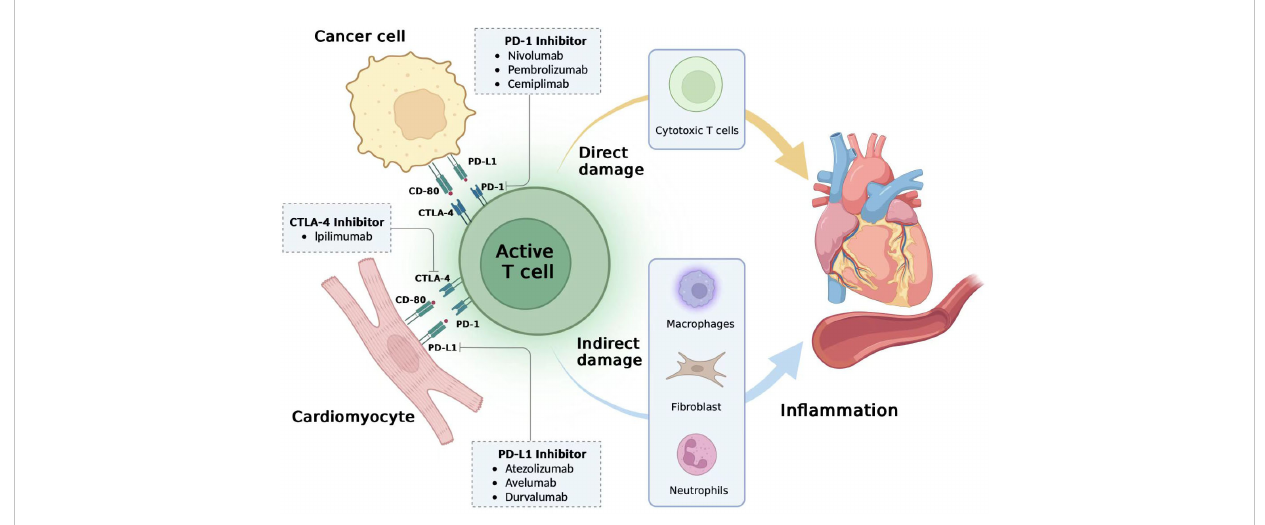
FIGURE 1 Potential mechanisms of immune-related cardiovascular adverse events. The mechanism of immune-related adverse cardiovascular adverse events (irACEs) is unclear, and it has been proposed that overactivation of T cells is the main cause. Cardiomyocytes may have a co-antigen progra m-med death-ligand 1 (PD-L1) or CD-80 on the surface of tumor cells, and they can normally bind to programmed death 1 (PD-1) or cytotoxic T-lymphocyte-associated antigen 4 (CTLA-4) on the T cell surface to prevent excessive activation of T cells. However, after the use of immune checkpoint inhibitors (ICIs) such as PD-1 inhibitors, PD-L1 inhibitors and CTLA-4 inhibitors, cardiomyocytes and tumor cells, CTLA-4/CD-80 and T cells are hyperactivated, T cells through cytotoxic T cells directly damage cardiovascular tissue, and recruit monocytes, macrophages, neutrophils and other in fl ammatory response, indirectly damage the cardiovascular system and fi nally cause irACEs.irACEs, immune-related cardiov-ascular adverse events; PD-1, programmed death 1; PD-L1, programmed death-ligand 1; CTLA-4, cytotoxic T-lymphocyte-associ ated antigen 4; ICIs, Immune Checkpoint Inhibitors. Figures generated with BioRender (https://